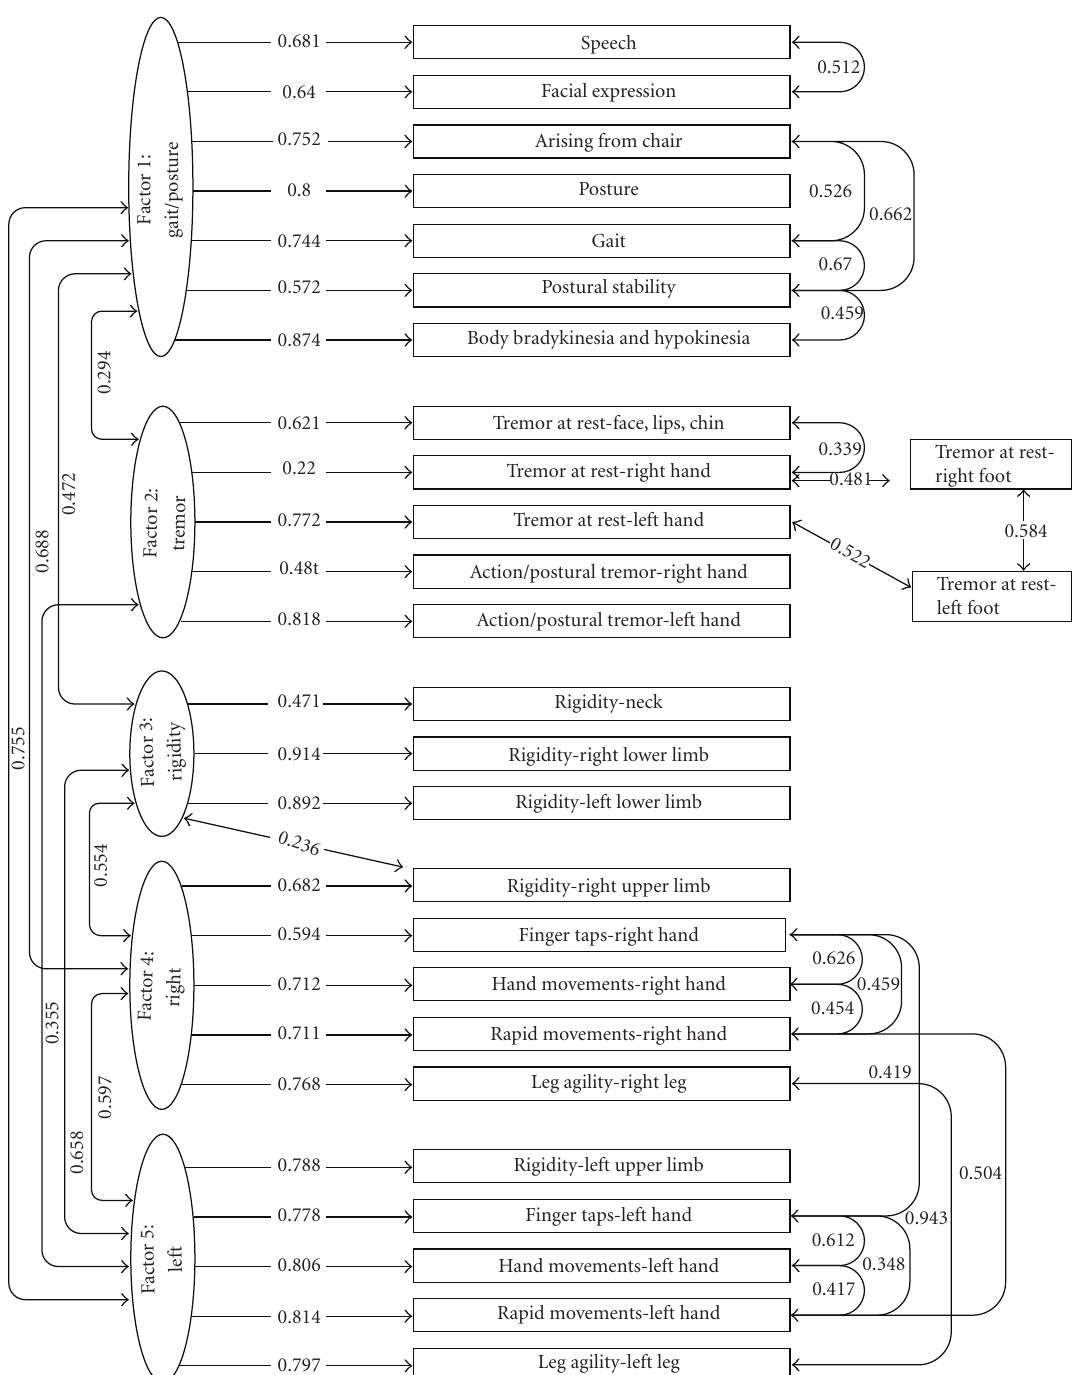
Figure 1: Confirmatory factor analysis results OFF medication. Single headed arrows indicate factor loadings, which double headed arrows indicate residual correlations.